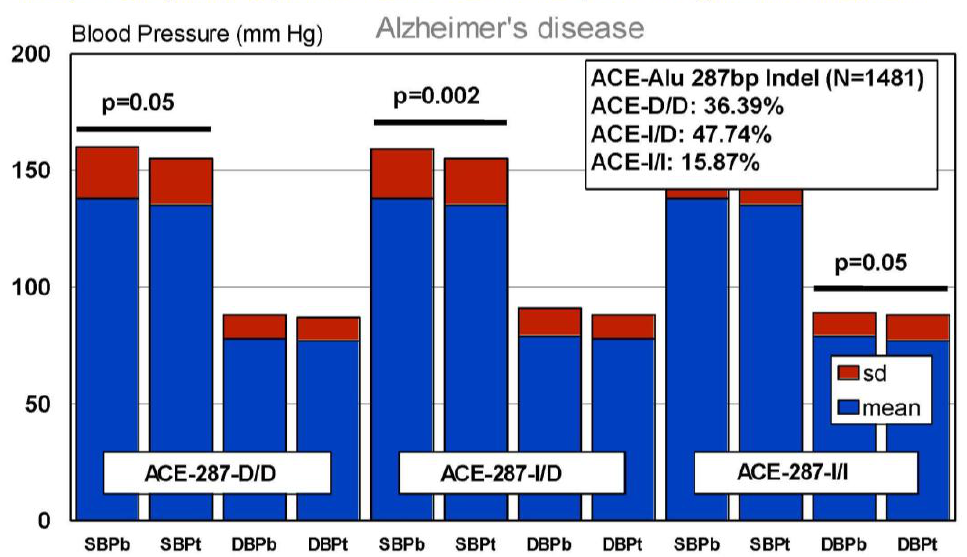
Figure 16. ACE -related blood pressure response to a hypotensive treatment. SBPb: Systolic blood pressure. SBPt: Systolic blood pressure (Enalapril, 10–20 mg/day). DBP: Diastolic blood pressure.